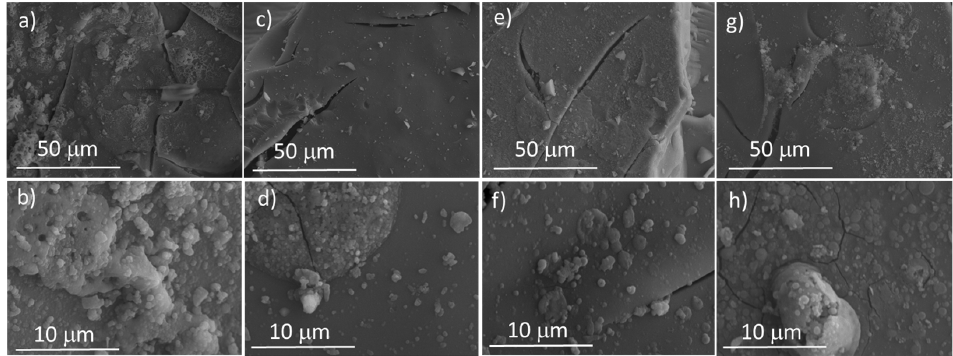
Figure 4. SEM micrographs obtained after 0 and 24 h in SBF for ( a , b ) MBG, ( c , d ) MBG-Zn1, ( e , f ) MBG-Zn3 and ( g , h ) MBG-Zn5.